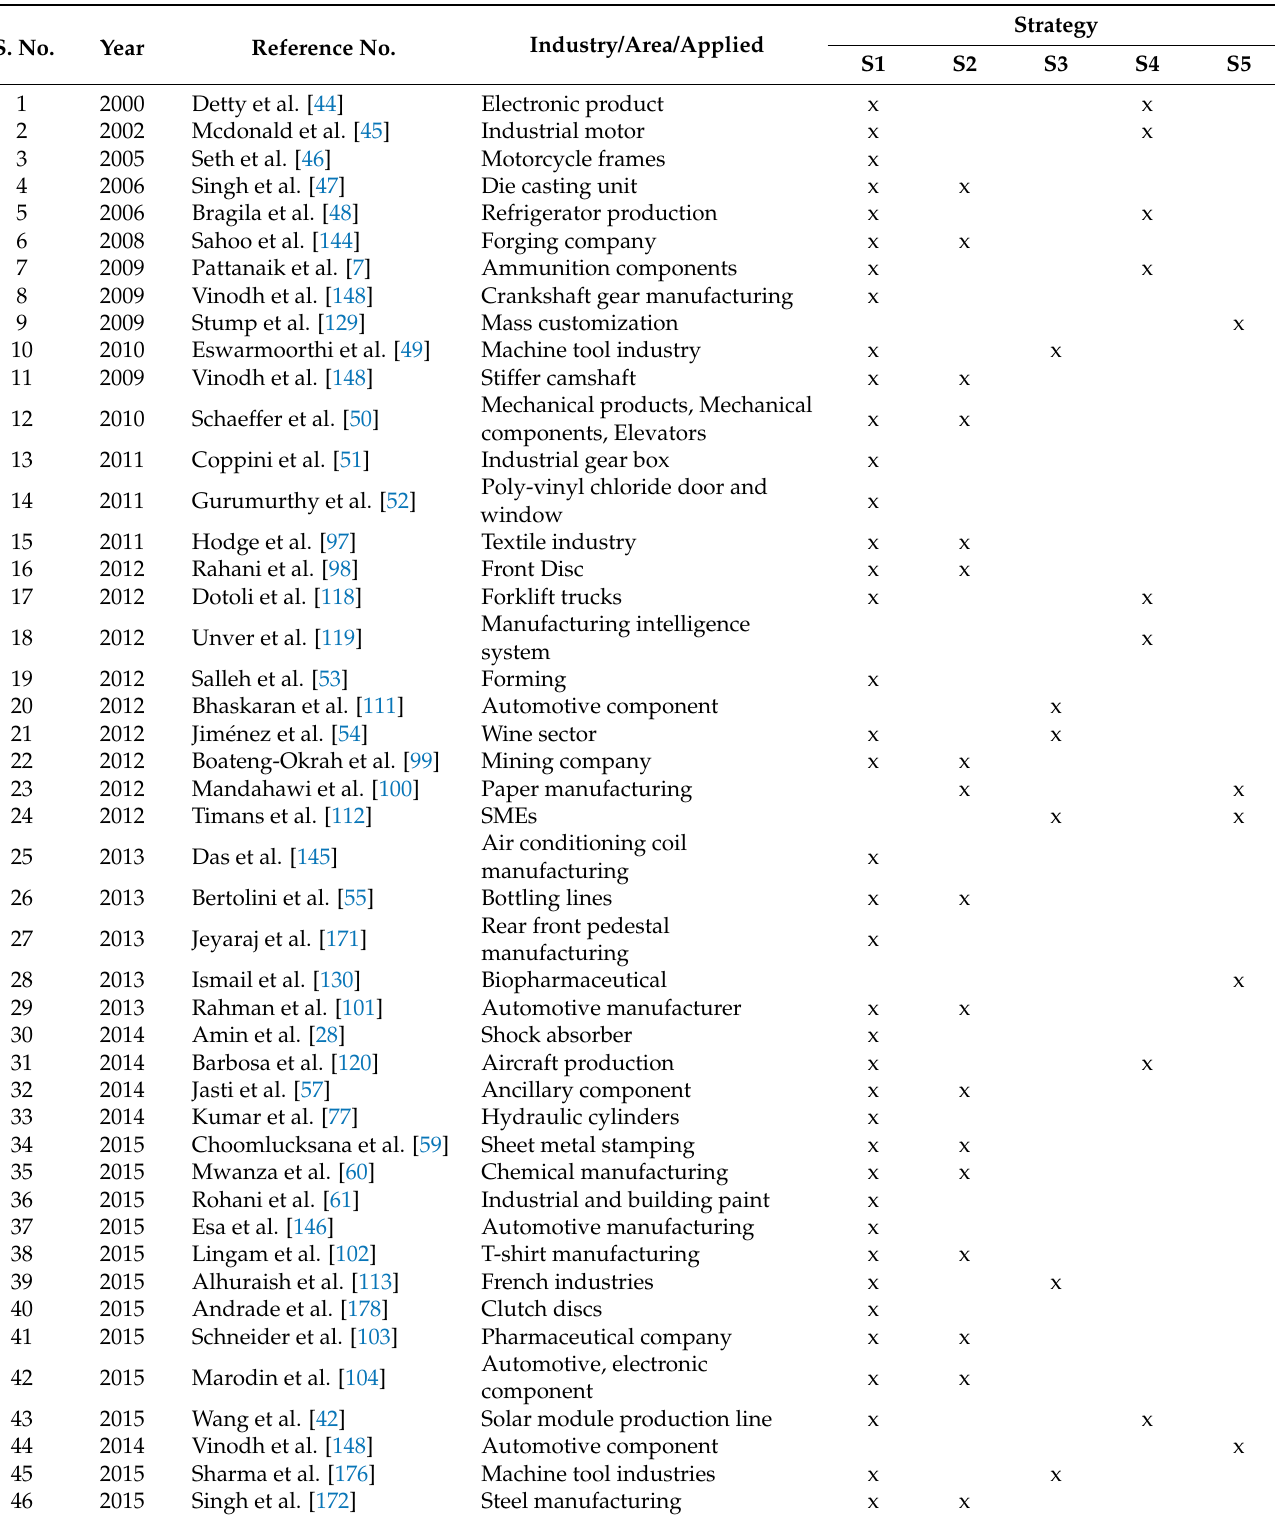
Table A1. Classification of the articles according to the strategy